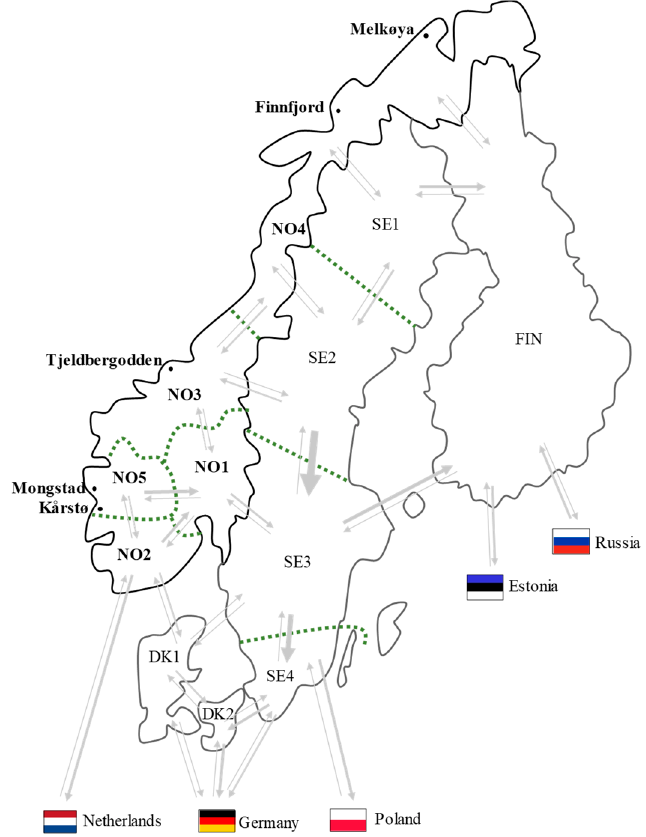
Figure 1. Overview of the Scandinavian power market bidding zones, also including gas-fired power plants in Norway (adjusted from [30]).